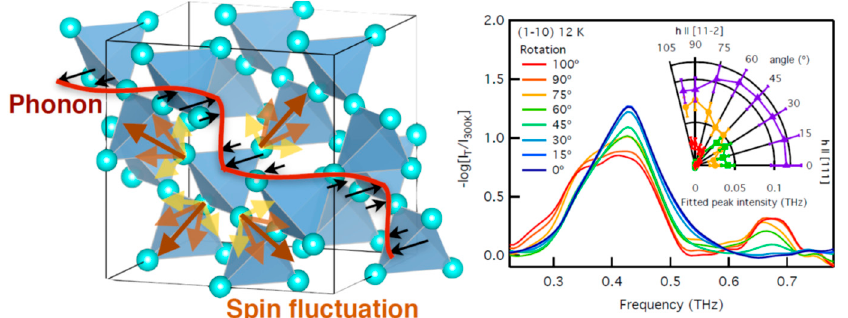
Figure 1. ( left ) Tb 3+ Pyrochlore network and graphical description of the vibronic process that involves the hybridization between a phonon and a crystal field excitation. ( right ) Angular dependence of the THz spectra recorder at 12